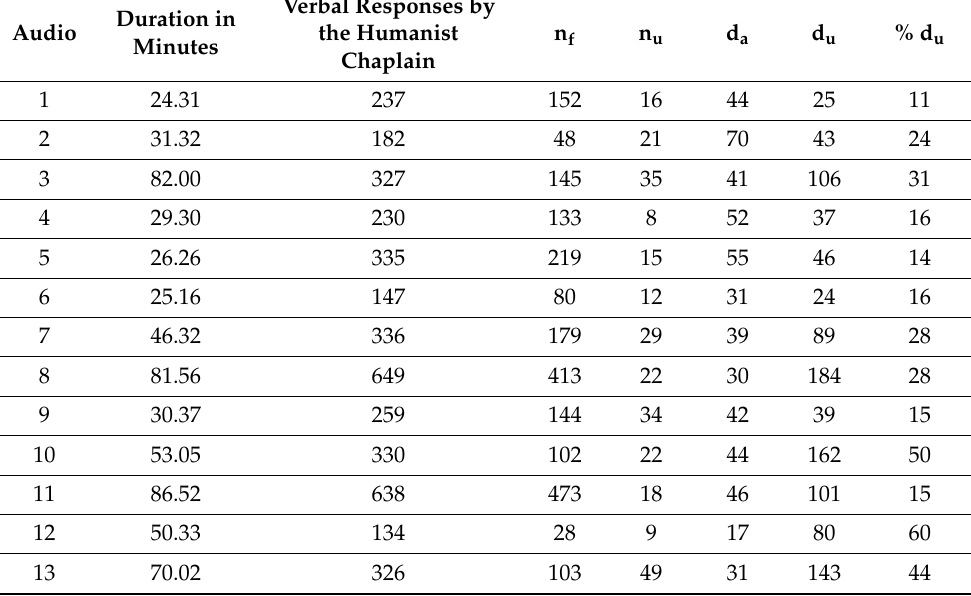
Table 1. Information on the audio recordings; n f —empathic following response; n u —empathic understanding response; d a —allowed directive response; d u —unallowed directive response; %d u — percentage of unallowed directive